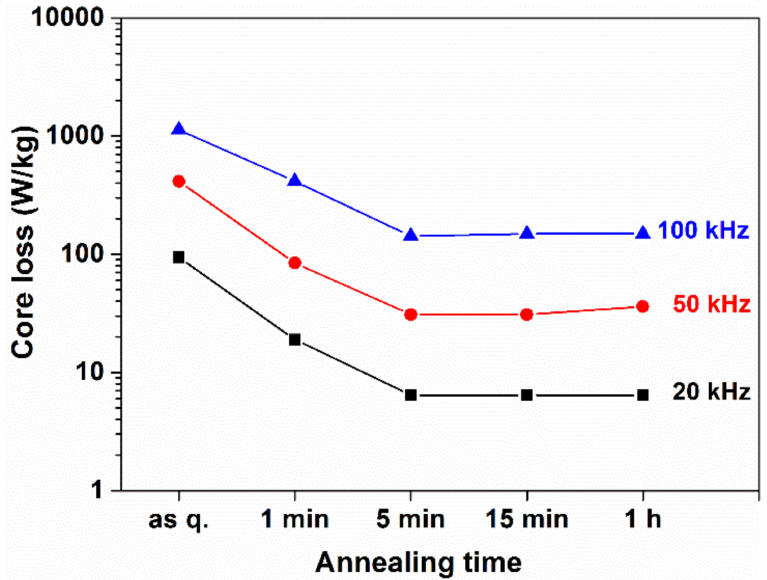
Figure 31. Change of magnetic loss at di ff erent frequencies versus the time of heat treatment at 793 K. Adopted from [117], with permission from Elsevier,